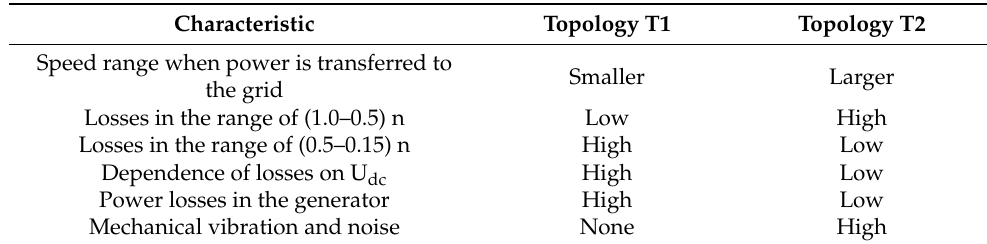
Table 2. Comparison of the characteristics of the AC/DC DC/AC converter with the DC/DC DC/AC converter.